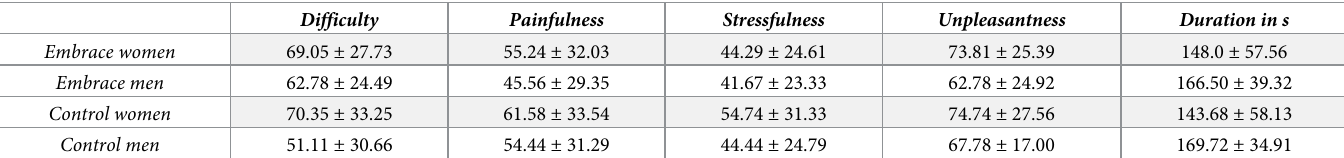
Table 6. Descriptive values (mean value and standard deviation) of the SECPT ratings and the duration of the SECPT broken down by condition and